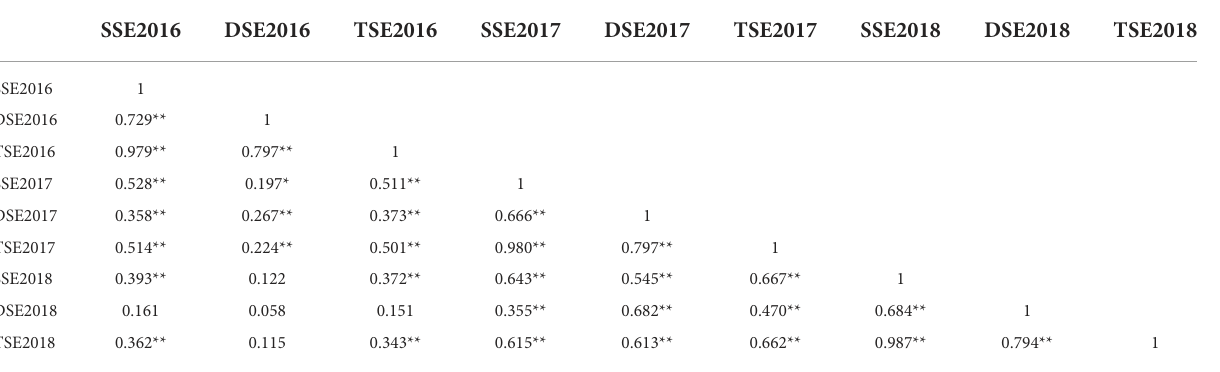
TABLE 2 Pearson correlation coefficients between the traits of Collection 1 over 3 years.